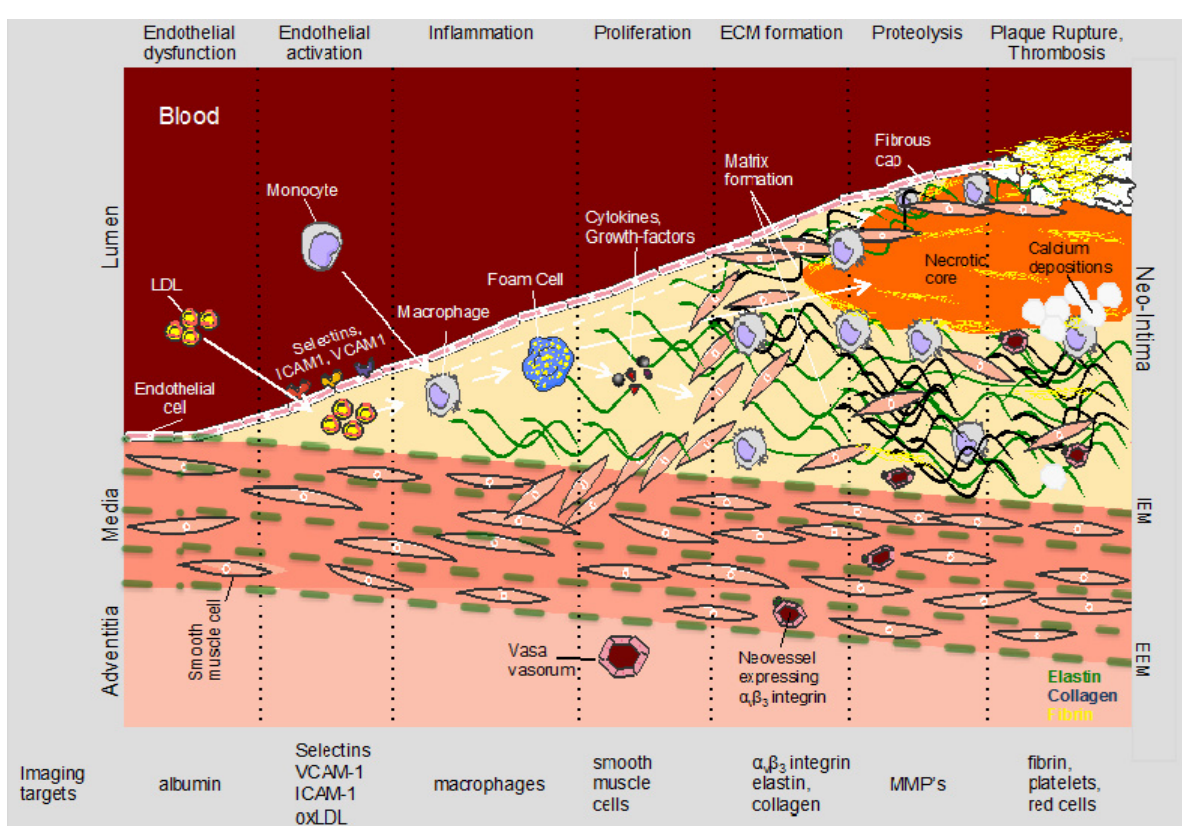
Figure 2. Schematic of biological processes and associated biological targets involved in the initiation, progression and complication of atherosclerosis. MR contrast agents have been shown useful for imaging of highly abundant proteins or cells such as collagen, elastin, fibrin, macrophages or VCAM-1 while PET tracer may be advantageous for visualization of low abundance targets such as MMPs or integrins. MR: magnetic resonance, PET: positron emission tomography, MMP: matrix